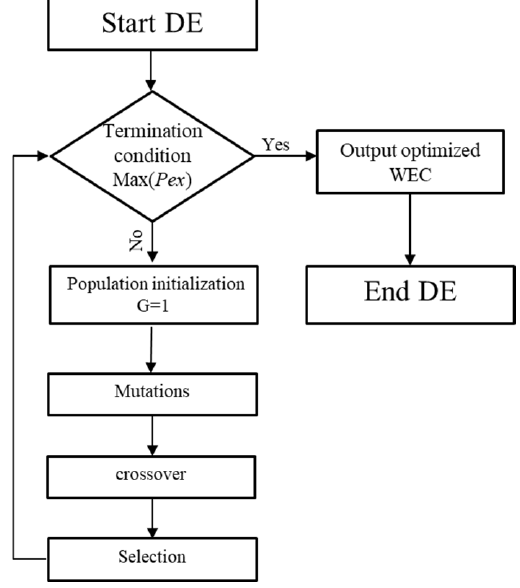
Figure 9. DE algorithm optimization process.